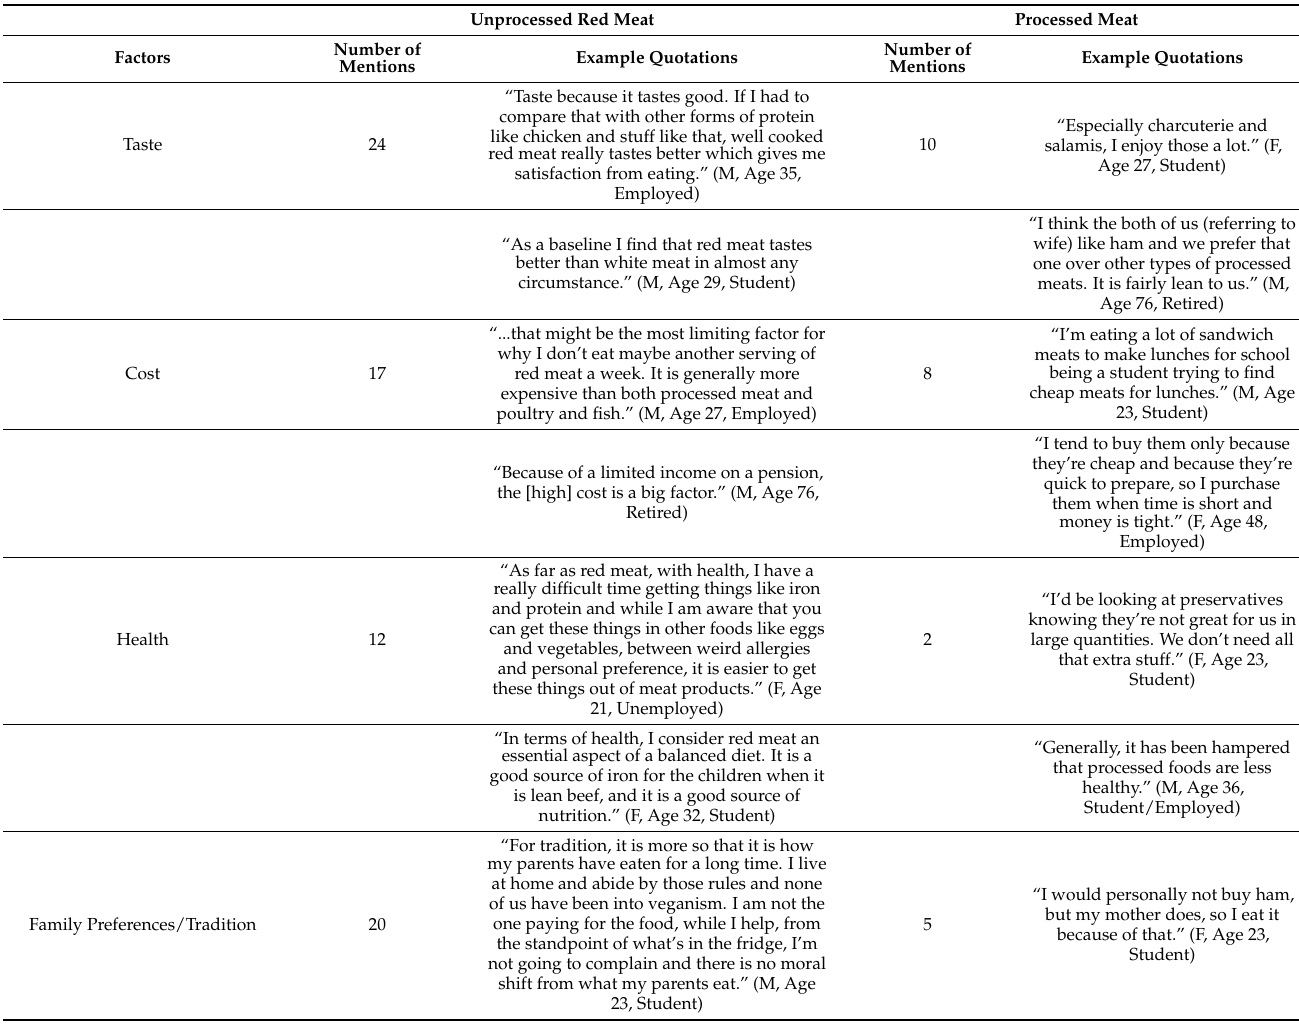
Table 2. Factors that impacted unprocessed red and processed meat